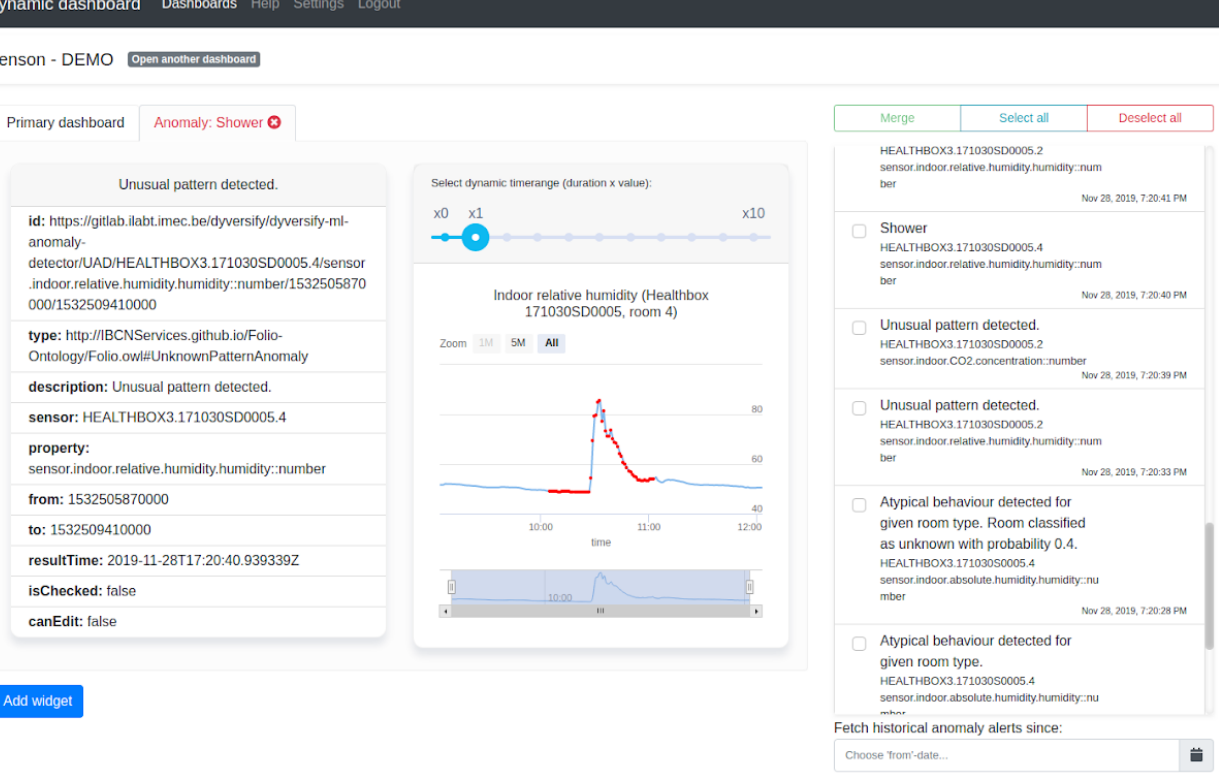
Figure 5. The dynamic dashboard GUI displaying a shower event. On the right, events are listed as they are detected. The user can also retrieve historical events using the input field at the bottom. The dashboard tab on the left displays an event detected by the unknown pattern